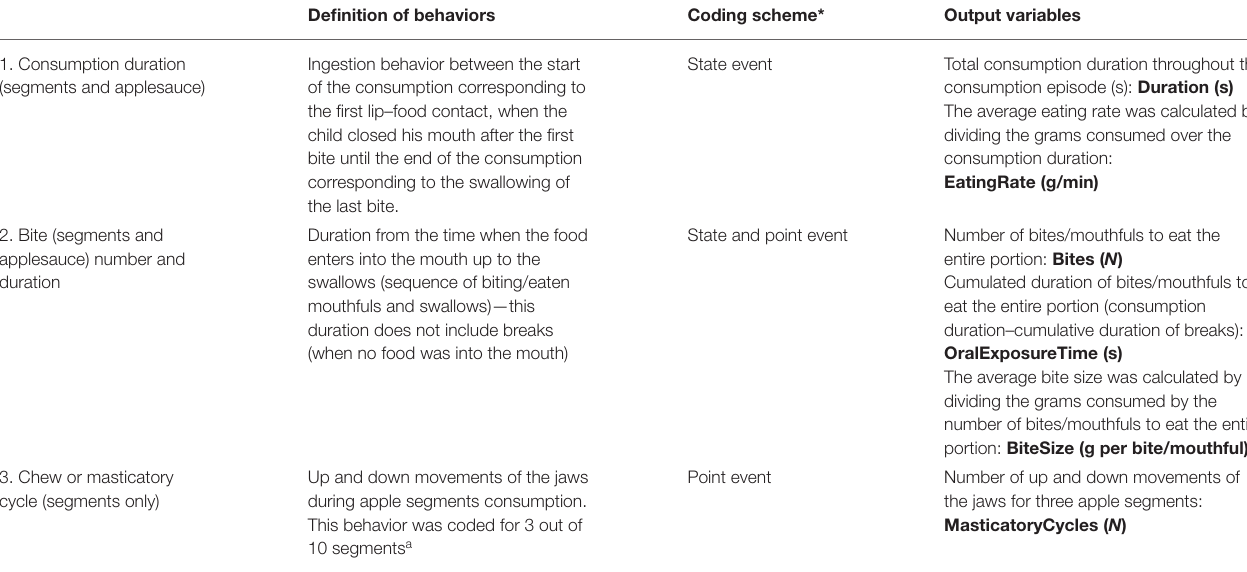
TABLE 1 | Video-coded oral processing behaviors, methodological parameters, and output